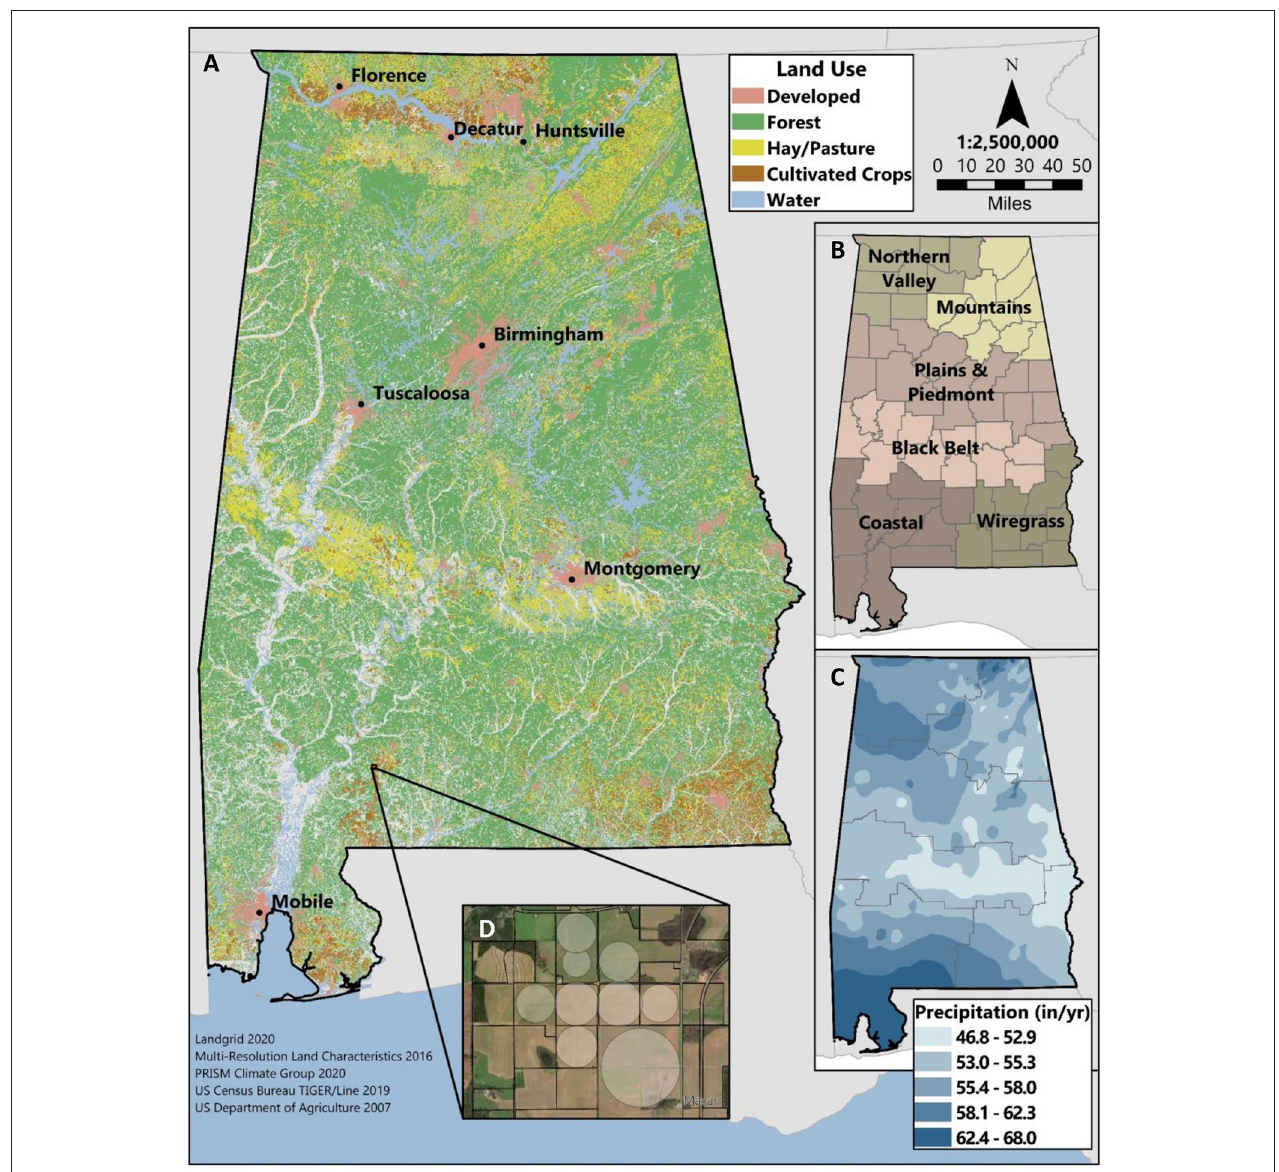
FIGURE 1 | (A) Classified map of land use in Alabama (MRLC, 2014); (B) agricultural regions considered in this study (USDA, 2007); (C) annual mean precipitation (PRISM Climate Group, 2020); and (D) example of parcel boundaries (Loveland Technologies, 2020) overlaid with center pivot irrigation polygons used in the analysis.